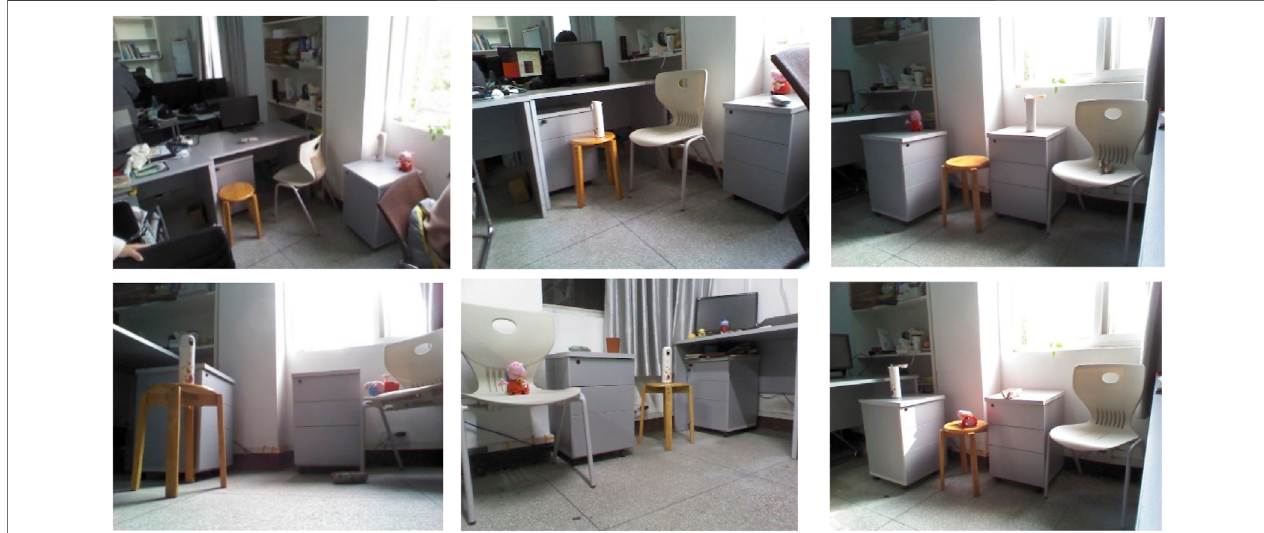
FIGURE 7 | Color images of different angles, backgrounds, and